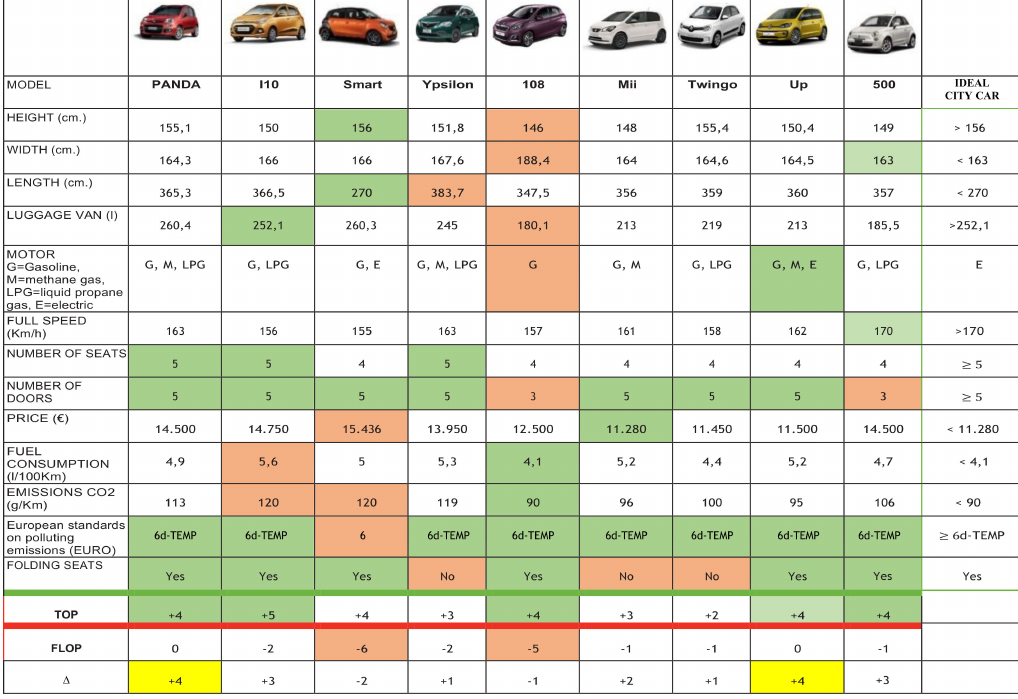
Figure 10. Benchmarking and Top-Flop analysis.